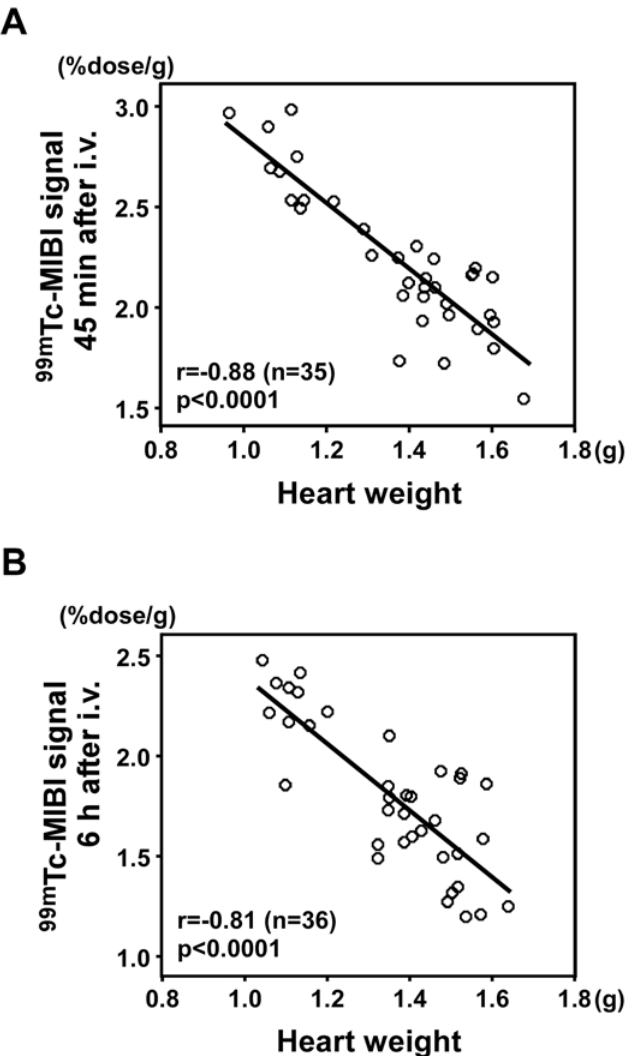
Figure 6. Correlation between 99m Tc-MIBI signals and heart weight. (A) 99m Tc-MIBI signal per gram of heart tissue 45 min after the injection was inversely correlated with heart weight (r = -0.88, n = 35, P < 0.0001). (B) 99m Tc-MIBI signal per gram of tissue 6 h after the injection inversely correlated with heart weight (r = -0.81, n = 36, P <